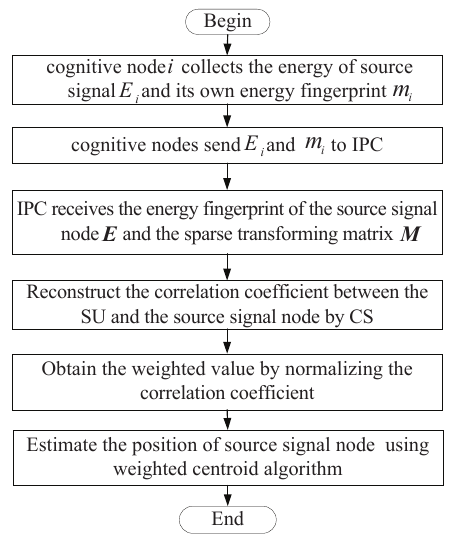
Figure 3. The node localization flow chart of the primary user localization algorithm based on compressive sensing